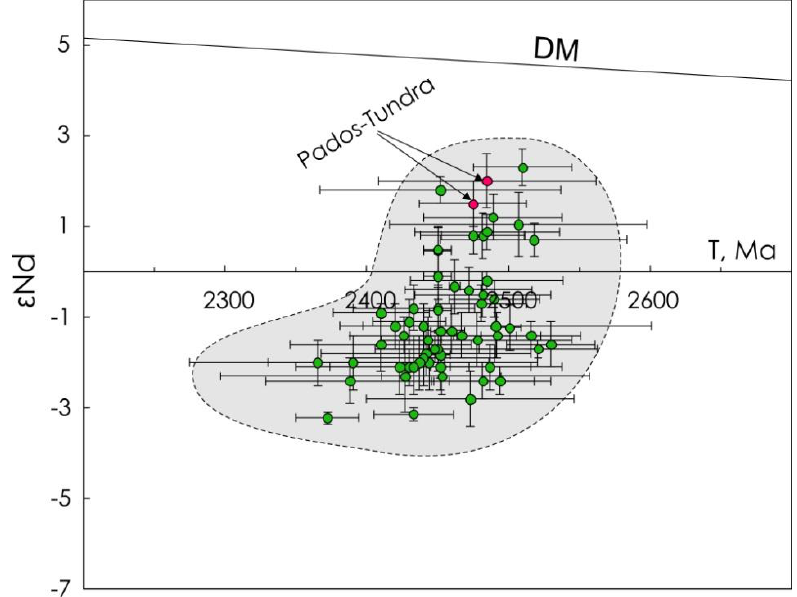
Figure 10. Plot for εNd(T) vs T for layered intrusions (2.53–2.39 Ga) in the Fennoscandian Shield and